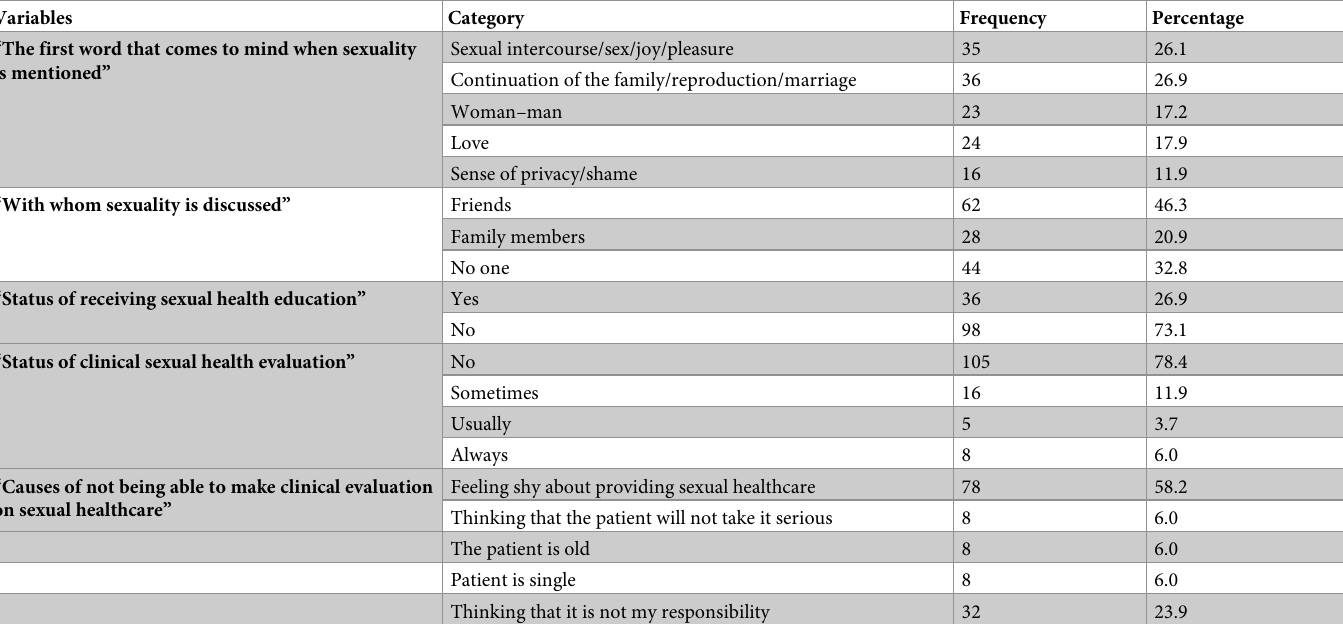
Table 2. Nursing students status of providing sexual healthcare (n = 134).